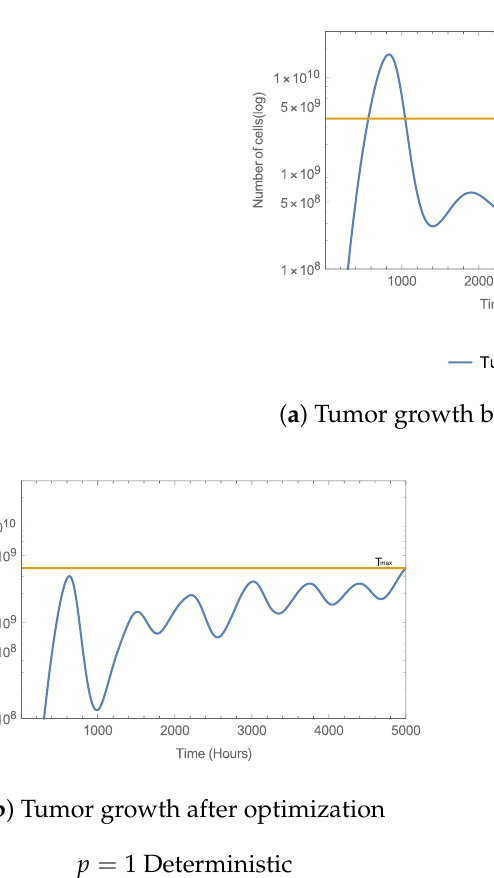
Figure 6. Panel ( a ) shows the tumor growth using a initial 80-day periodic schedule with dose size V = 1.93548 × 10 5 over 5000 h using a total dose of 1.31613 × 10 7 . Panel ( b ) the tumor growth after the optimization of the cost function using p = 1, the optimized schedule makes the tumor cells count to stay below T max = 3.7 × 10 9 . Panel ( c ) the tumor growth after the optimization of the cost function using p = 0.5, the optimized schedule makes the tumor cells count go below T max = 3.7 × 10 9 for most of the 5000 h. The stochastic case has less final tumor cell